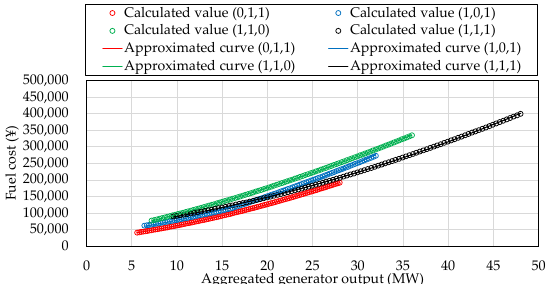
Figure 3. Approximated fuel cost functions (“¥” means “any currency unit is applicable”).